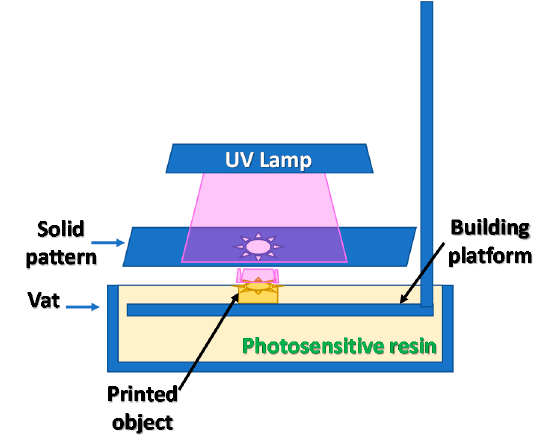
Figure 2. Origin of 3D printing; diagram of the principle of operation.